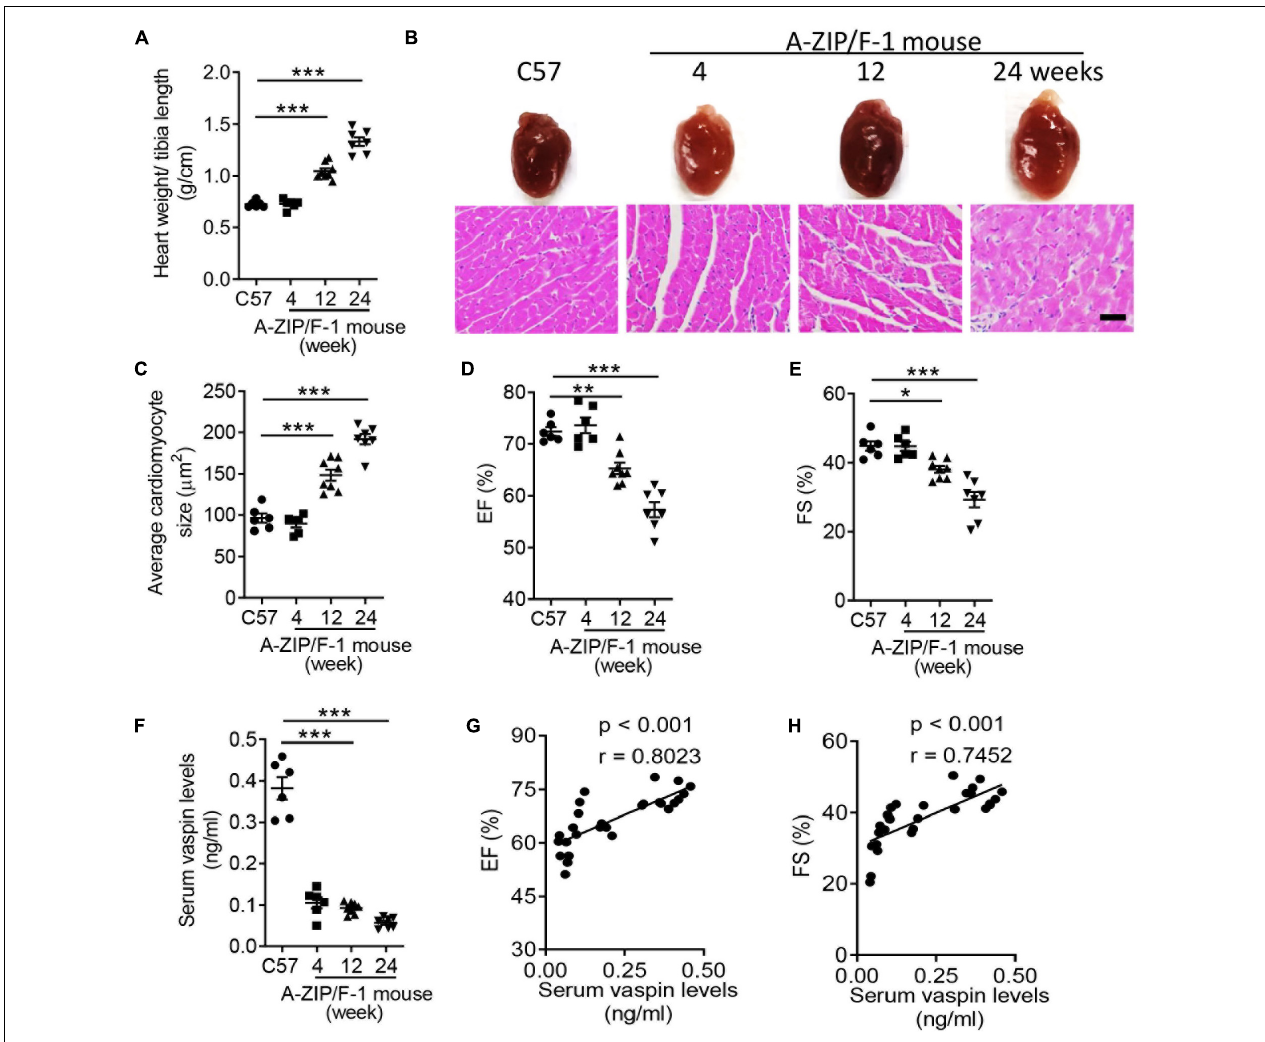
FIGURE 1 | Cardiac dysfunction is negatively correlated with serum level of vaspin in A-ZIP/F-1 lipoatrophic mice. (A) The ratio of heart weight/tibia length of 4-, 12-, and 24-week-old A-ZIP/F-1 mice. The C57BL/6J (C57) mice were the control group. (B,C) Representative images of whole hearts and cardiac slides were stained with hematoxylin and eosin solution (B) , and quantitative analysis of average cardiomyocyte size (C) . Scale bar = 20 µ m. (D,E) Echocardiographic analysis of mouse cardiac ejection fraction (EF) (D) and fractional shortening (FS) (E) . (F) Enzyme-linked immunosorbent assay (ELISA) analysis of mouse serum levels of vaspin. (G,H) The correlation between serum levels of vaspin and EF and FS in A-ZIP/F-1 mice. Results are shown as mean ± SEM, and n = 6–8 mice/group. * p < 0.05, ** p < 0.01, *** p <